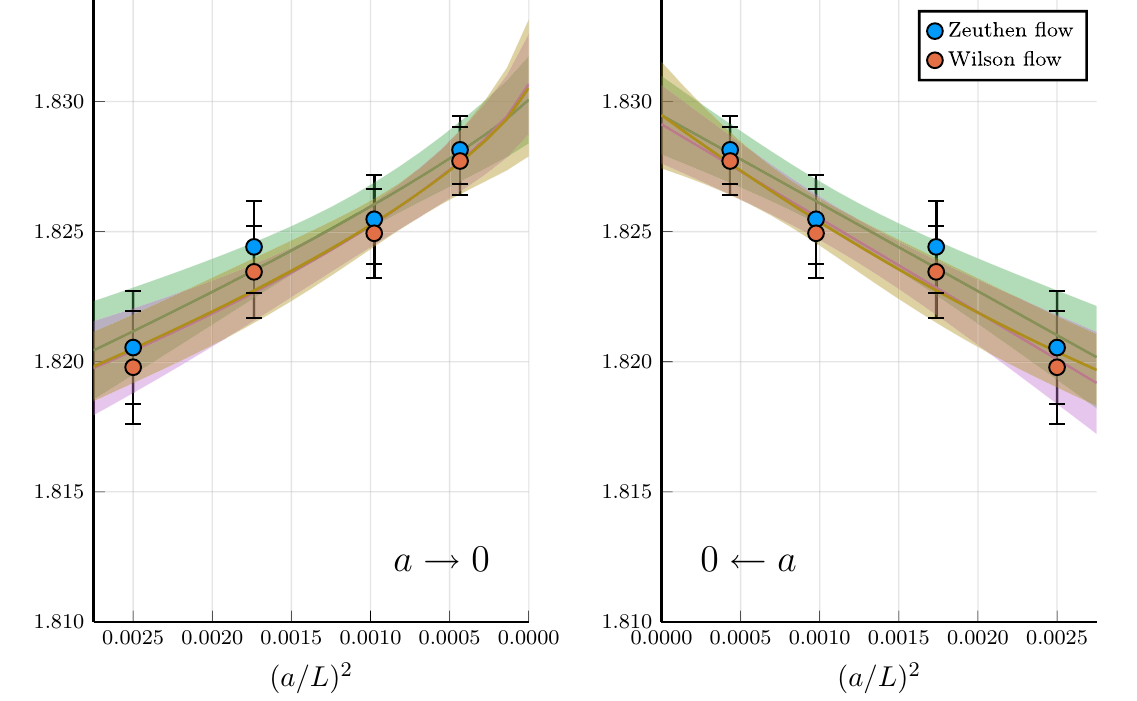
of “magnetic” and “electric” definitions of the GF coupling; the blue symbols are from the dataset of Ref.